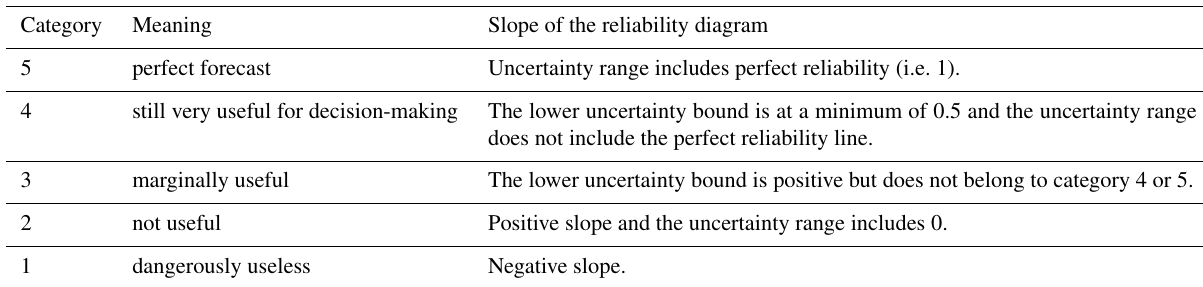
Table 3. Characterization of forecast reliability following Weisheimer and Palmer (2014). The uncertainty range of the slope is characterized by the 75% confidence interval derived from 1000 bootstrap samples with